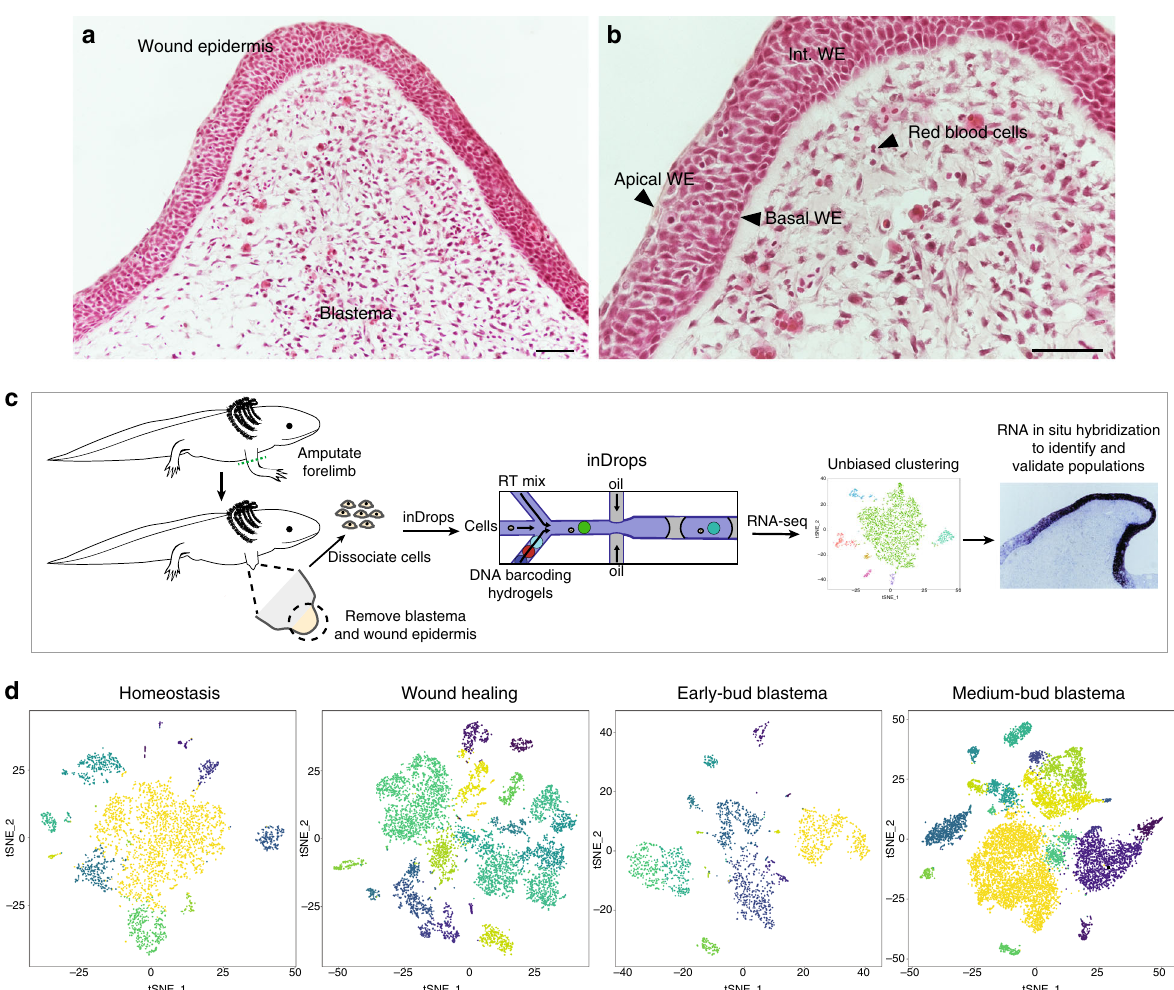
Fig. 1 Single-cell RNA-seq of the adult axolotl limb. a Hematoxylin and eosin staining of medium-bud blastema with overlying wound epidermis. Cell types labeled in a , b based on morphology/location. Scale bars are 100 μ m, n = 4 animals. c Strategy for identifying the cell populations that compose the regenerating axolotl limb. d t -SNE plot of cells collected from homeostasis ( n = 2 animals), wound healing ( n = 3 animals), early-bud blastema ( n = 2 animals), and medium-bud blastema ( n = 6 animals). Each dot is a cell and colors represent individual populations and do not re fl ect the same population between time